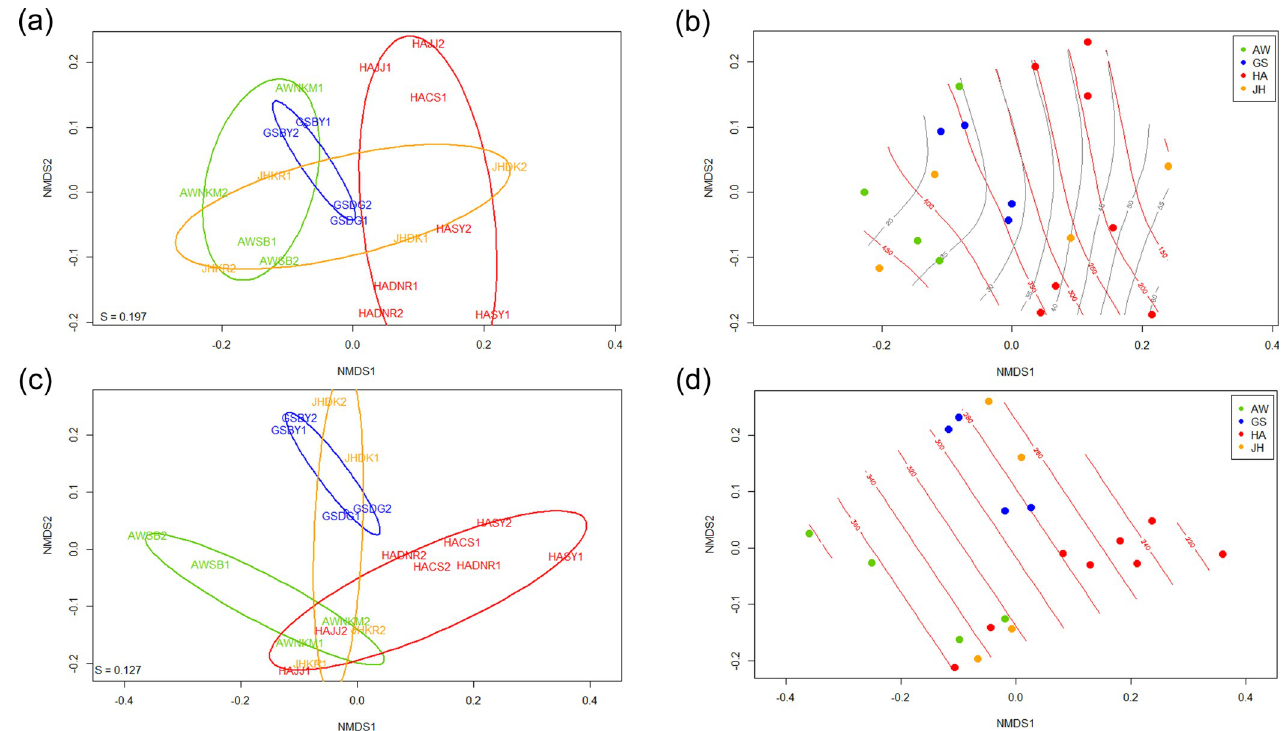
Fig 2. Exploratory analysis of microbial communities by unconstrained ordination plots using Non-metric Multidimensional Scaling (NMDS) with 16S rRNA gene sequence (a & b) and GeoChip functional gene hybridization data (c & d) with ellipses determined by the standard deviation of point scores (a & c) and with gradients of two most important soil variables by GAM fitting (b-nitrate (red) and %silt (grey) & d- K-exchange capacity).